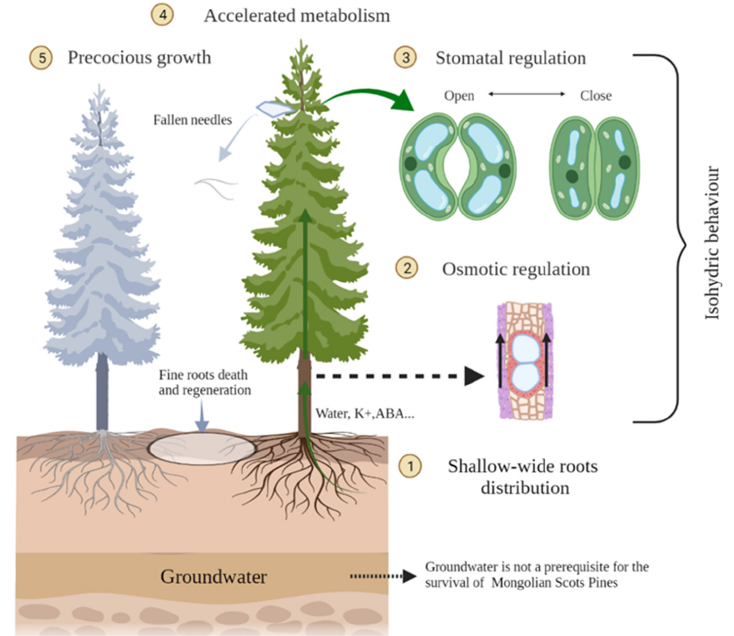
Figure 2. Schematic diagram showing the five key strategies behind the drought-resistance and the climate change adaptability of Mongolian Scots pine: shallow–wide root distribution, osmotic regulation, stomatal regulation, accelerated metabolism, and precocious growth. The schematic diagram was created with BioRender.com (accessed on 21 April 2022).